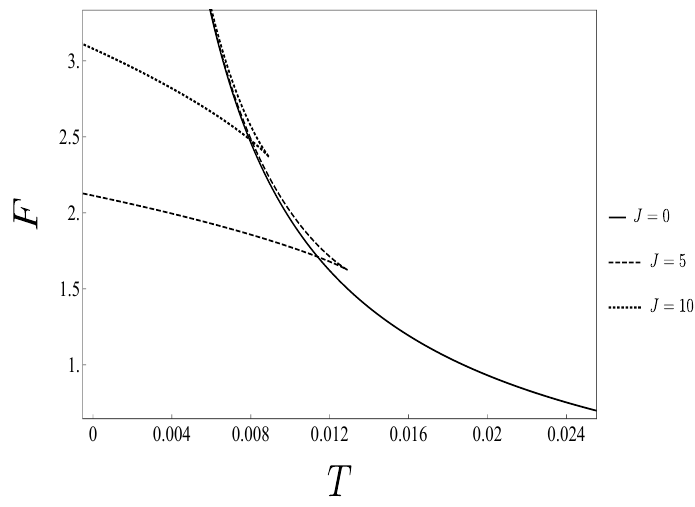
Figure 1 . Free energy: zero charge. The F (cid:0) T diagram is displayed for (cid:12)xed n = 1 and various angular momenta J . We observe a very similar behavior to what happens for the Schwarzschild ( J = 0) black hole and the Kerr black hole ( J 6 = 0)